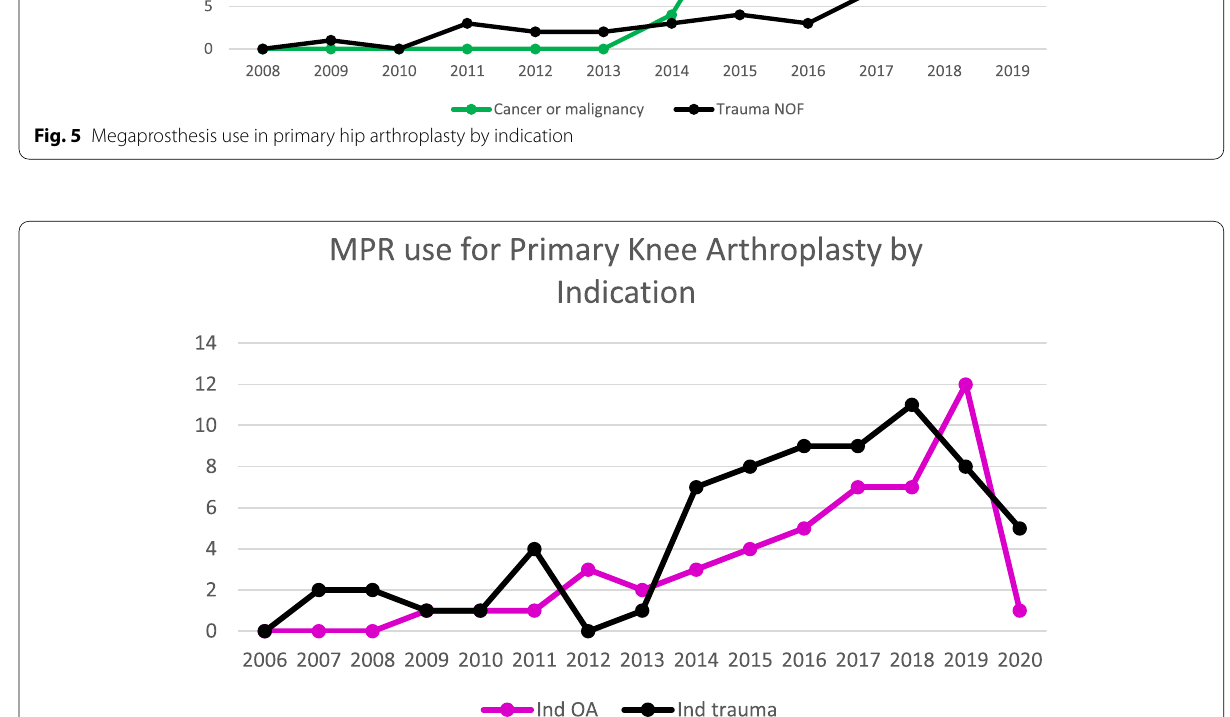
Fig. 6 Megaprosthesis use in primary knee arthroplasty by indication